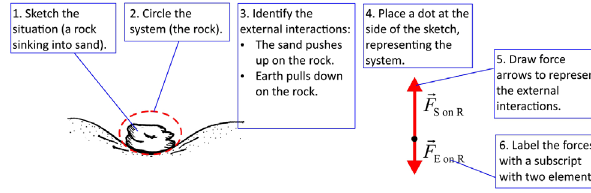
FIG. 8. Steps that the students are supported to follow when drawing a force